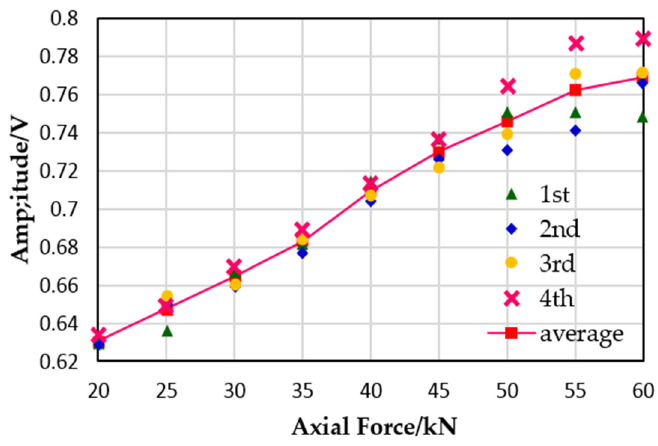
Figure 8. The peak amplitude of the focused signal under different preloads of the first specimen.